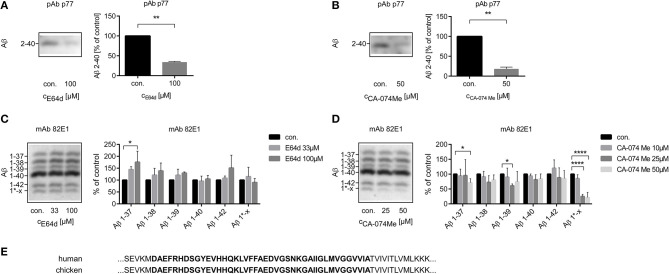
Quantification of the relative amounts of Aβ 2-x (A,B) and of Aβ 1-x (C,D) in conditioned medium of cultured chicken astrocytes after the treatment with E64d (A,C) or CA-074 Me (B,D) over 48 h compared to controls using 1D Urea-SDS-PAGE followed by immunoblot analysis with anti-Aβ 2-x polyclonal antibody (pAb) p77 (A,B) or anti-Aβ 1-x monoclonal antibody (mAb) 82E1 (C,D). Twenty milliliter (A,B) or 4 ml (C,D) sample volume were used. Aβ 2-40 was significantly reduced after the treatment with E64d (A) or CA-074 Me (B). No significant reduction of the amounts of Aβ 1-40 or Aβ 1-42 was detected after E64d (C) or CA-074 Me (D) treatment. The labeling of the different Aβ 1-x peptide variants is based on a series of synthetic Aβ (Aβ 1-37, Aβ 1-38, Aβ 1-39, Aβ 1-40, and Aβ 1-42) and their isoelectric point in 2D Urea-SDS-PAGE (Supplementary Figure 1). A specific Aβ variant, designated as Aβ 1*-x, was effectively reduced by CA-074 Me treatment (D). Panel (E) shows a section of the amino acid sequences of human and chicken APP, which contains the amino acid sequence of Aβ 1-42 (bold) and adjacent amino acids. In contrast to rodents, no differences in the amino acid sequence exist between humans (NP _958816.1) and chicken (NP _989639.1) in this part of APP (NCBI Reference Sequences are given, http://www.uniprot.org). Statistics: (A)
n = 3, ratio paired T-Test t(2) = 31.43 p < 0.01, (B)
n = 3, ratio paired T-Test t(2) = 12.05 p < 0.01, (C)
n = 3, Kruskal-Wallis test Aβ 1-37, H (2) = 5. 793, p < 0.05, eta2 = 0.63, Kruskal-Wallis test Aβ 1-38, H (2) = 3.310, p > 0.05, Kruskal-Wallis test Aβ 1-39, H (2) = 3.310, p > 0.05, Kruskal-Wallis test Aβ 1-40, H (2) = 0.8276, p > 0.05, Kruskal-Wallis test Aβ 1-42, H (2) = 0.1036, p > 0.05, Kruskal-Wallis test Aβ1*-x, H (2) = 1.471, p > 0.05, (D)
n = 5, Kruskal-Wallis test Aβ 1-37, H (3) = 10.45, p < 0.05, eta2 = 0.41, Kruskal-Wallis test Aβ 1-38, H (3) = 6.529, p > 0.05, Kruskal-Wallis test Aβ 1-39, H (3) = 8.236, p < 0.05, Kruskal-Wallis test Aβ 1-40, H (3) = 6.101, p > 0.05, Kruskal-Wallis test Aβ 1-42, H (3) = 4.178, p > 0.05, Kruskal-Wallis test Aβ 1*-x, H (3) = 17.23, p < 0.001, eta2 = 0.79. Dunn's post-hoc test was performed for comparisons to vehicle treated control (con.). Selected comparisons are indicated as follows*p < 0.05; **p < 0.01, and ****p < 0.0001).